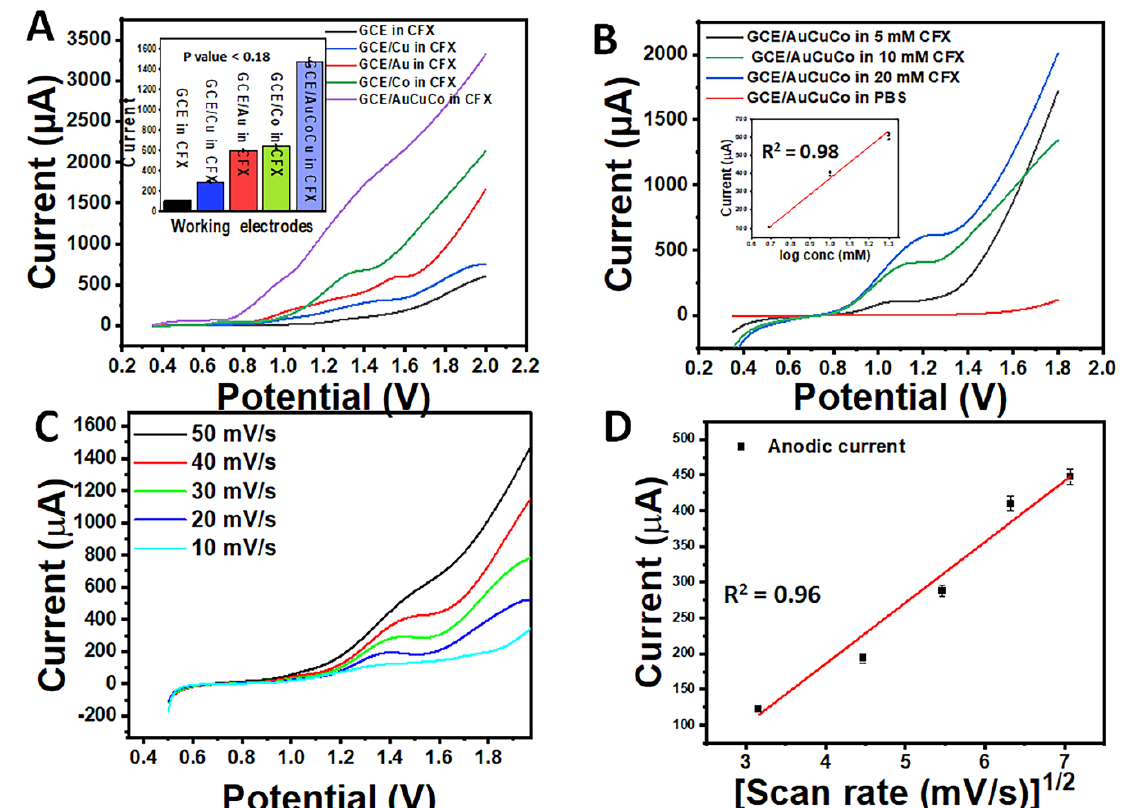
Figure 8. ( A ) LSV responses of GCE (black curve), GCE/Au (red curve), GCE/Co (green curve), GCE/Cu (blue curve), and GCE/AuCoCu (violet curve) matrices in 40 mM CFX dissolved in PBS (5 mM, pH 7, and scan rate 50 mV/s), inset showing the current histogram of all electrodes dipped in CFX; ( B ) Concentration-dependent control experiment of GCE/AuCoCu-imprinted matrix in PBS (red curve) and the GCE/AuCoCu surface in 5 mM (black curve), 10 mM (green curve), and 20 mM (blue curve) CFX, inset displaying the calibration plot; ( C ) Scan-rate-dependent study of GCE/AuCoCu matrix in 20 mM CFX, with the scan rate ranging between 10 and 50 mV/s; ( D ) Corresponding peak values showing a linear graph with a correlation coefficient of 0.96.